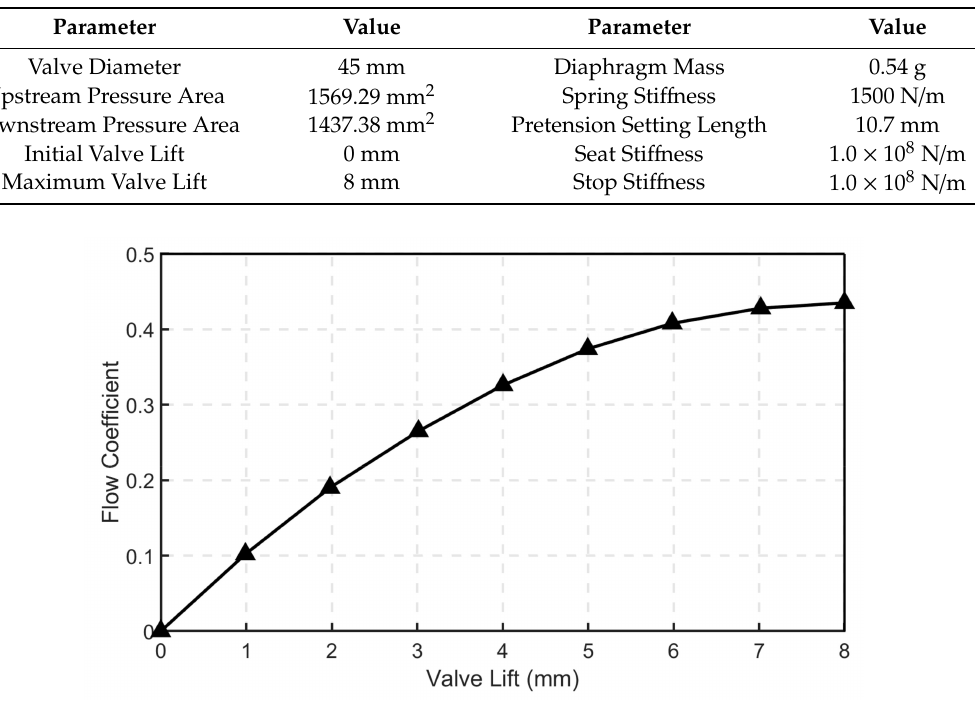
Figure 10. The variation curve of flow coe ffi cient with valve lift.